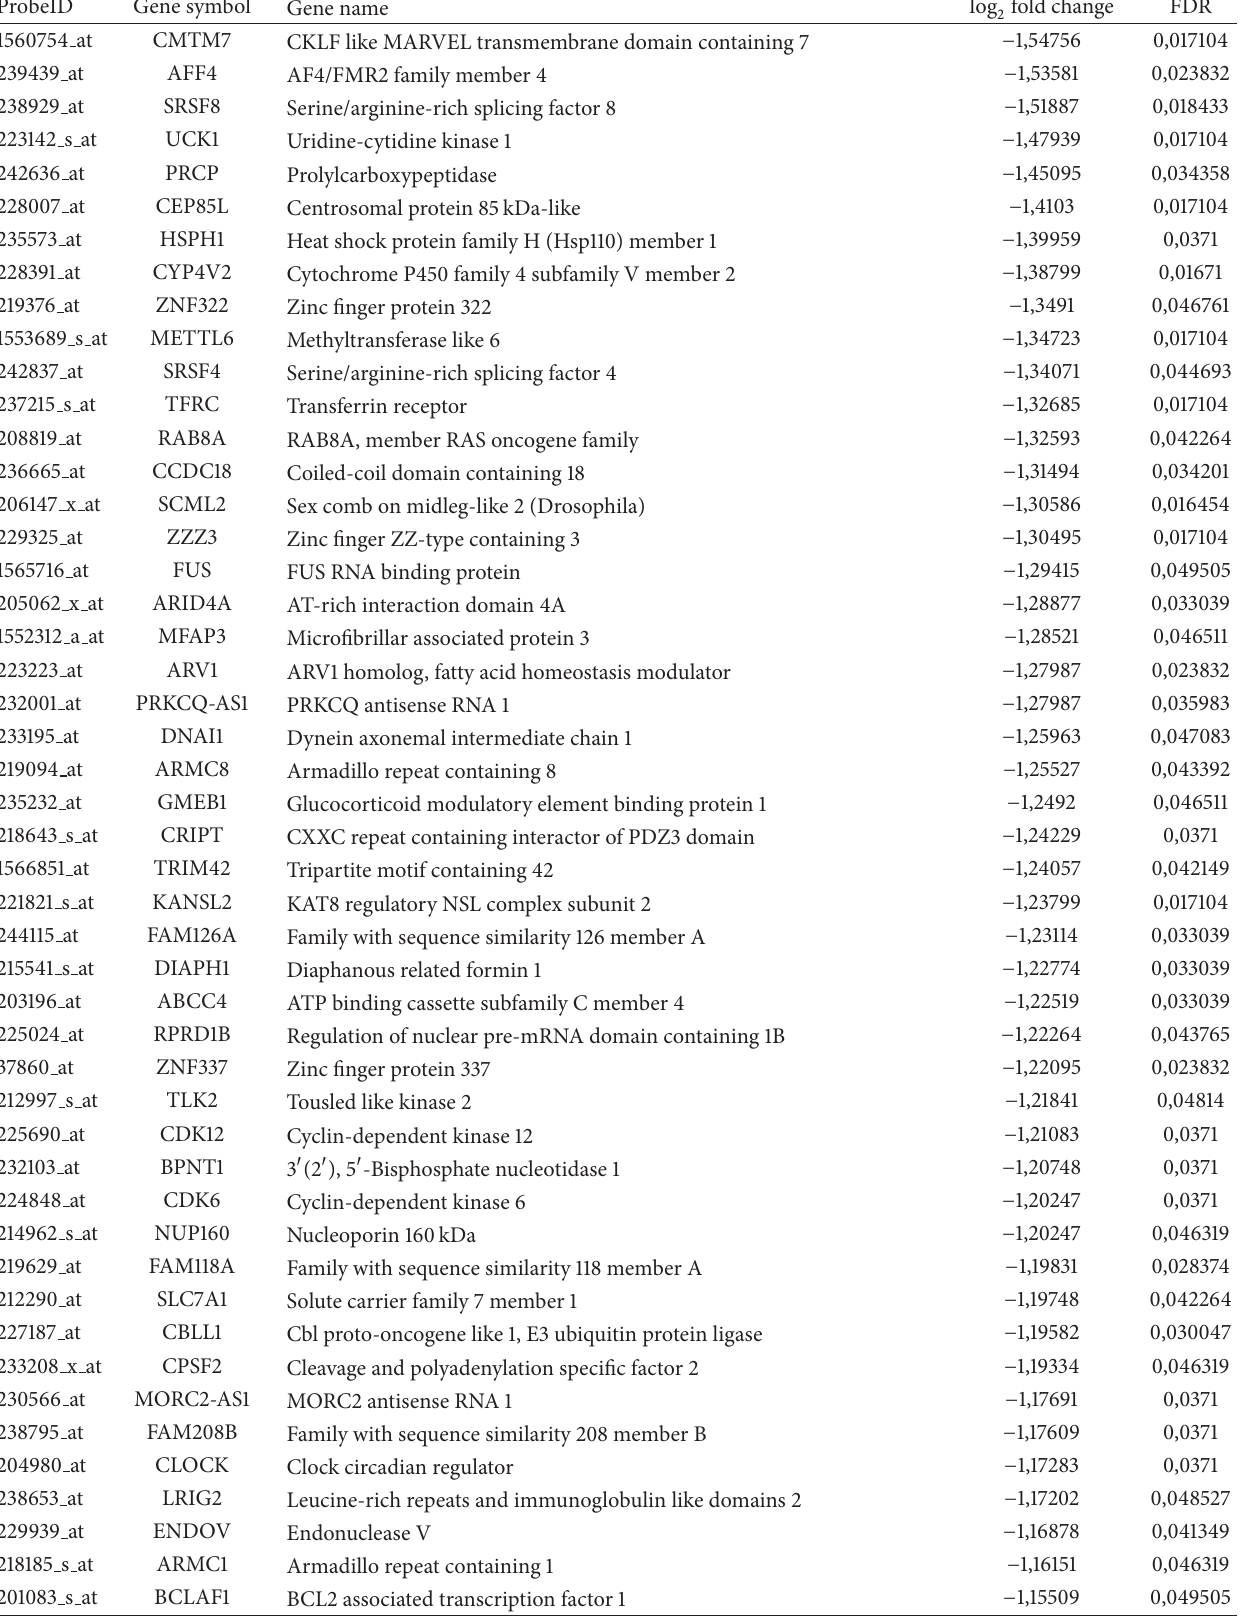
Table 1: Differentially expressed genes identified in dataset